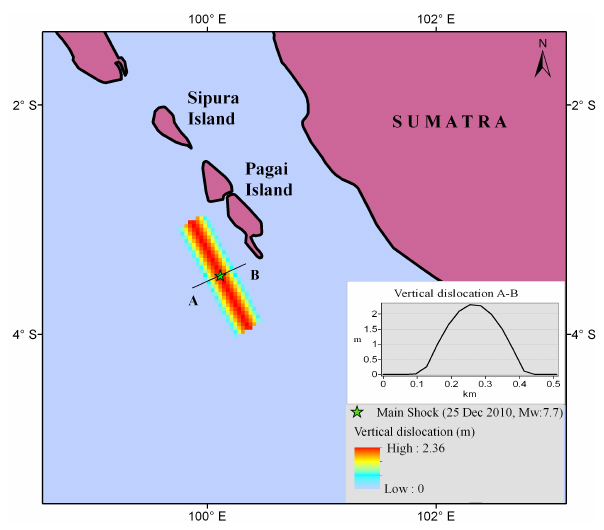
Fig. 2. Initial cosinusoidal hump tsunami source of the 2010 Kepu- launan Mentawai